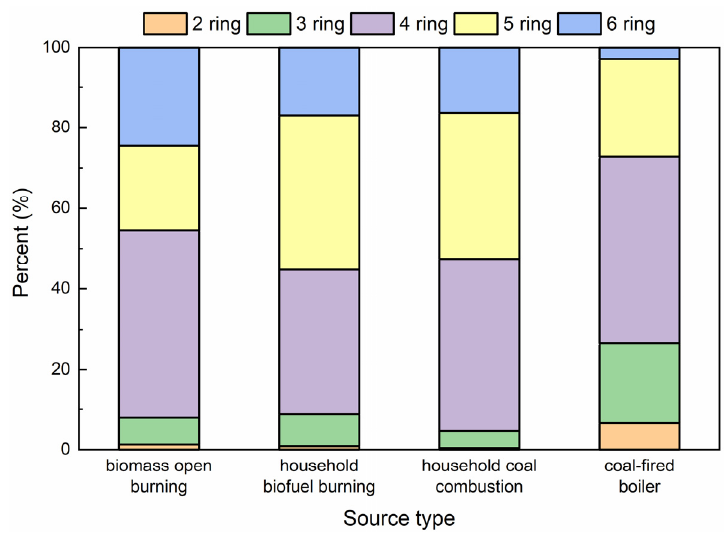
Figure 2. Distribution characteristics of PAH rings.